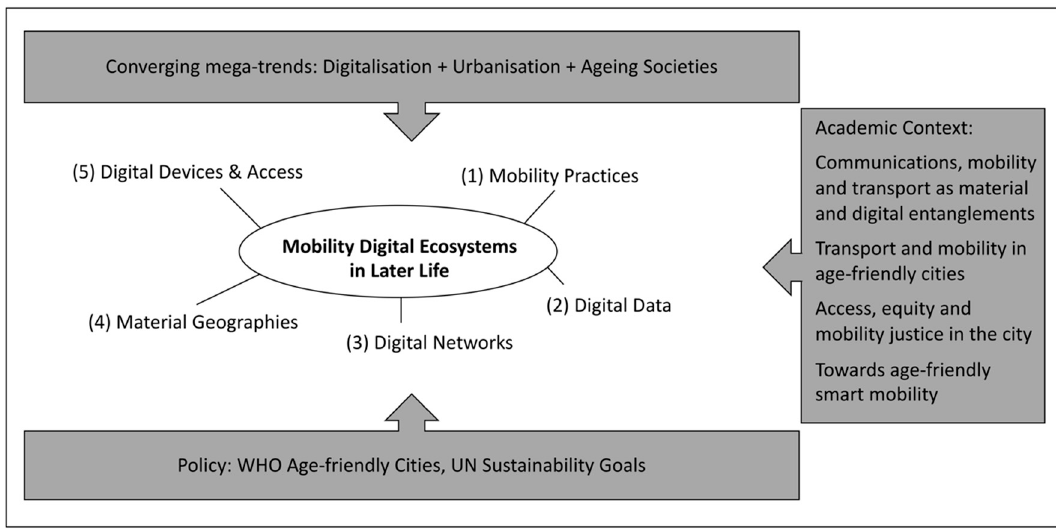
Figure 2. The framework “Mobility Digital Ecosystems in Later Life” and its five elements, within the larger societal (top), policy (bottom) and academic (right) contexts.